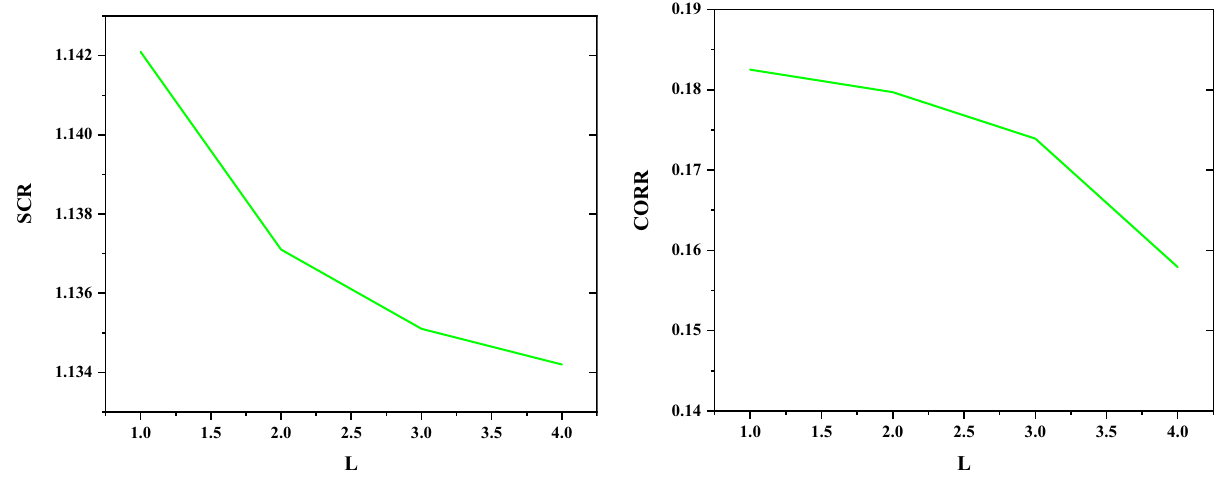
Figure 4: P – M di ff usion ( SCR ) based on gradient automatic threshold estimation.